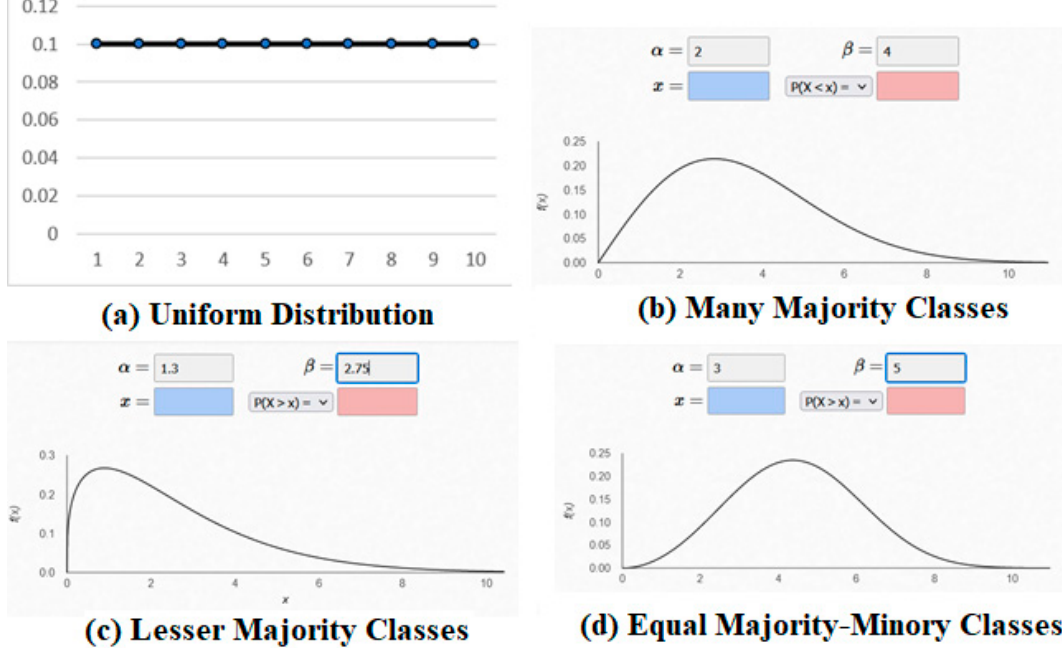
Figure 3. Various imbalance distributions used.